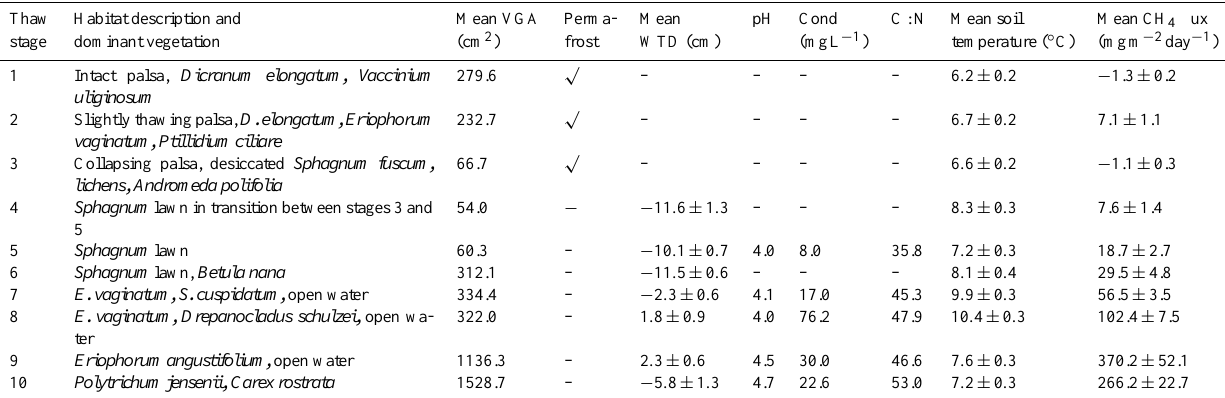
Table 1. Details of each thaw stage – habitat description and dominant vegetation, vascular plant green area (VGA), presence or absence of permafrost, mean growing season water table depth (from 19 days of sampling over 2years), mean surface water pH, reduced conductivity (Cond) and C:N ratio, growing season mean soil temperature at 10cm depth below surface and mean growing season CH 4 fluxes. Details on CO 2 flux for each thaw stage can be found in Table 4. WTD was only reported for stages with a water table on more than 5 sampled days. All values reported after ± are standard